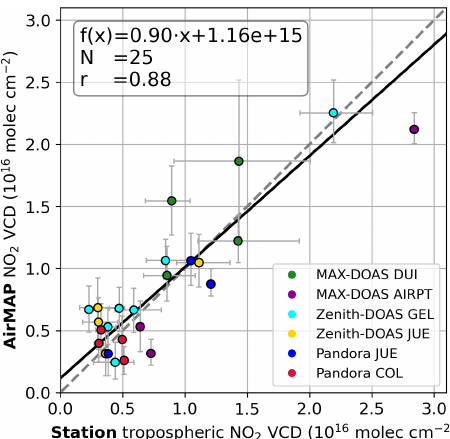
Figure A6. The same as Fig. 6 but with different error bars. Scat- ter plot showing the stationary ground-based NO 2 VCDs averaged in a time interval of 20min closest to the AirMAP overpass data, which are averaged over a 500m × 500m box around the station site. Error bars represent the 10th and 90th percentile within the 500m × 500m grid boxes and 20min time